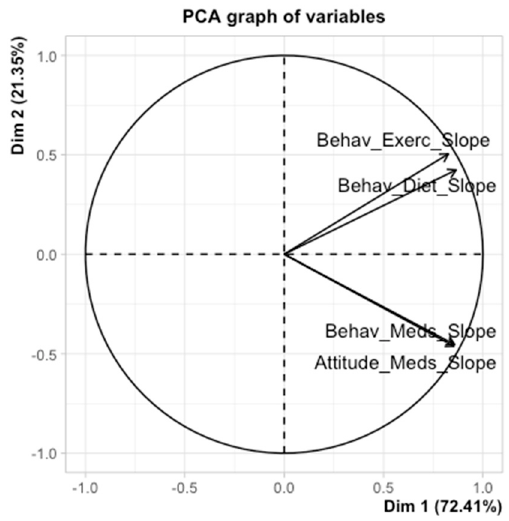
Figure 2. Principal Component Analysis: Preventive and Treatment Health Behaviors.